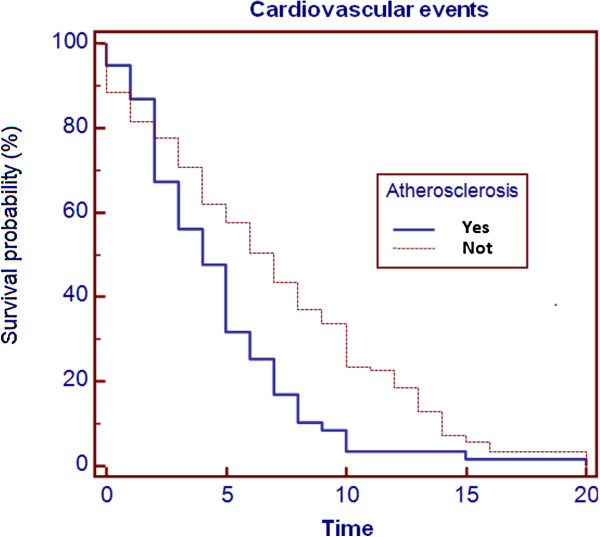
Event-free survival according to the Kaplan Meyer function.